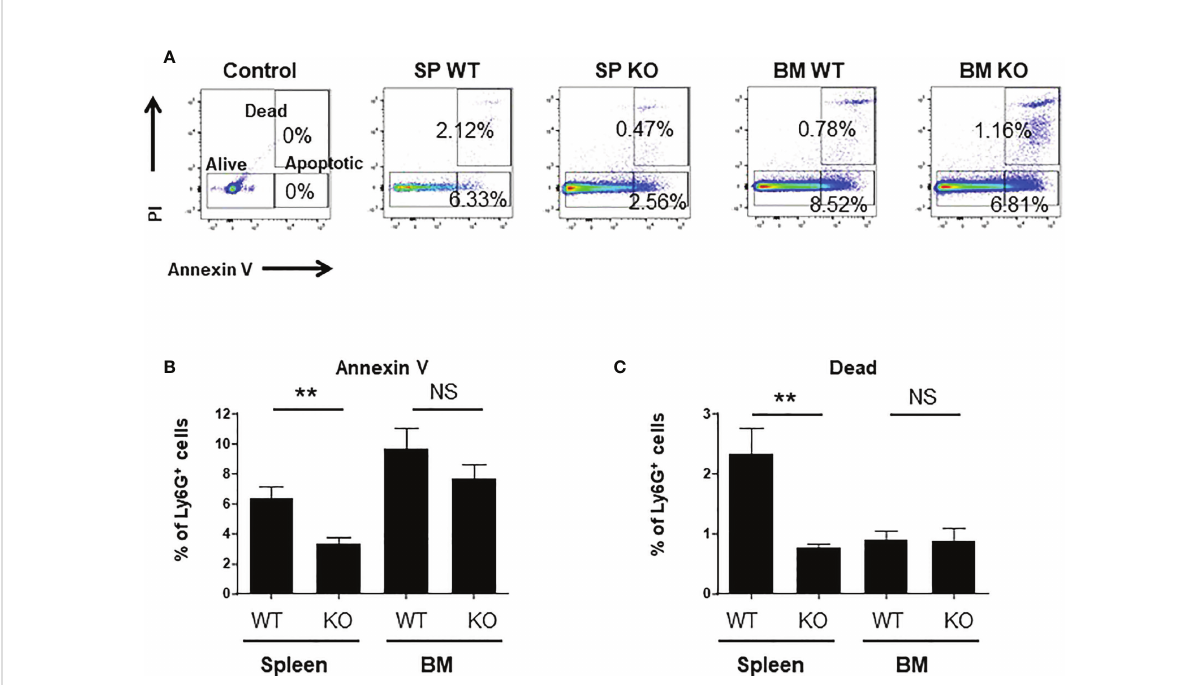
FIGURE 5 spleen Cxcr2-/- neutrophils exhibit a reduced apoptosis and mortality. (A) Gating strategy to identify alive, dead and apoptotic cells based on Annexin V and PI staining. Control plot corresponds to cells labelled with cell surface markers, but not with Annexin V and PI (B) Measure of the percentage of apoptotic neutrophils in the spleen and BM of WT and Cxcr2-/- animals by annexin V staining. (C) Same measure of dead cells by PI staining. Results are expressed as the percentage of CD11b+ Ly6G+ neutrophils and represent the mean ± SEM of 6 animals; Mann-Whitney test, NS: non-signi fi cant, **p <